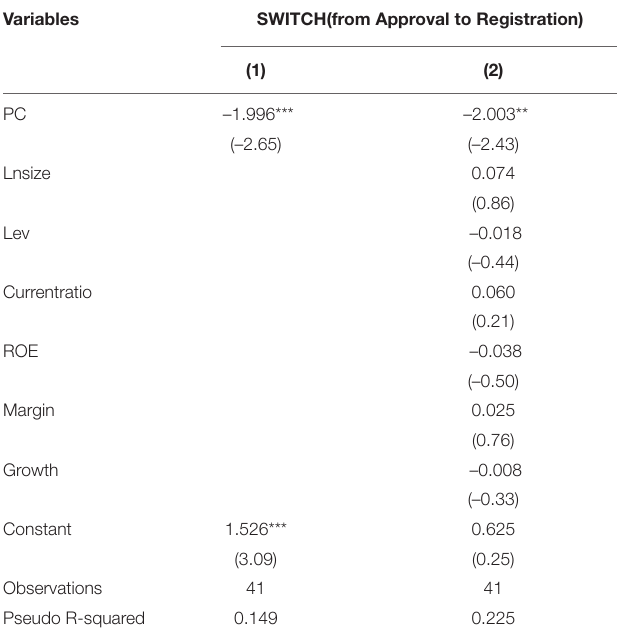
TABLE 12 | The propensity for registration system or approval system in multiple rounds of application among politically connected firms.